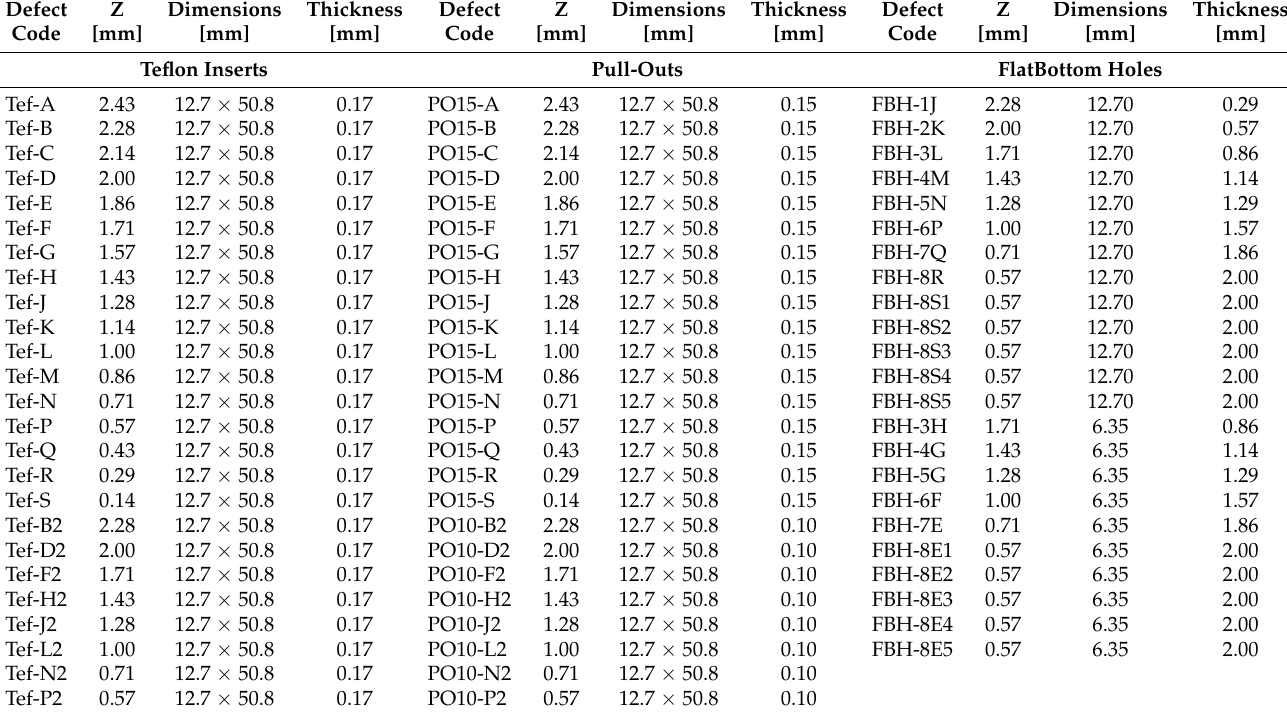
Table 1. Defect specifications for the CFRP Plate, Z is the depth of the defect below the inspected surface. Thickness is the defect thickness or thickness of the holes in case of the FBH type of defect.